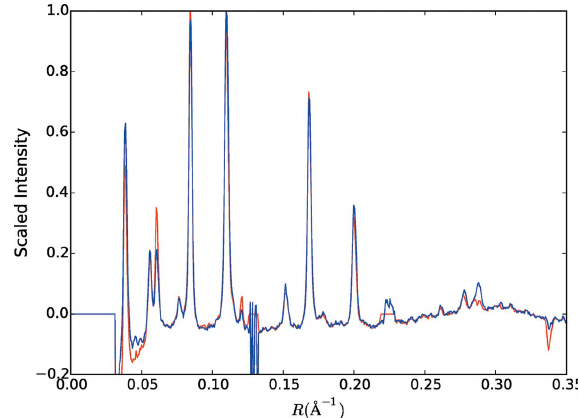
Figure 8 Intensity through the equator of Fig. 4( b ) (red) and through the equator of Fig. 4( c ) (blue), as described in the